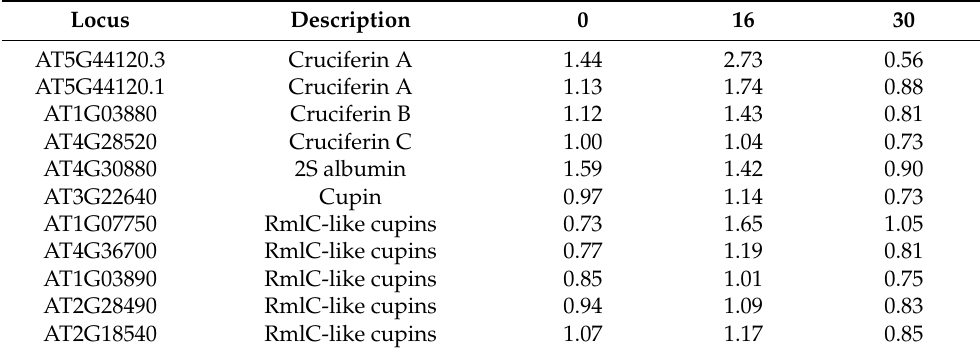
Table 3. The protein expression ratios ( prt6 − /Col − ) of SSPs in dry seeds, and in seeds imbibed for 16 and 30 h.